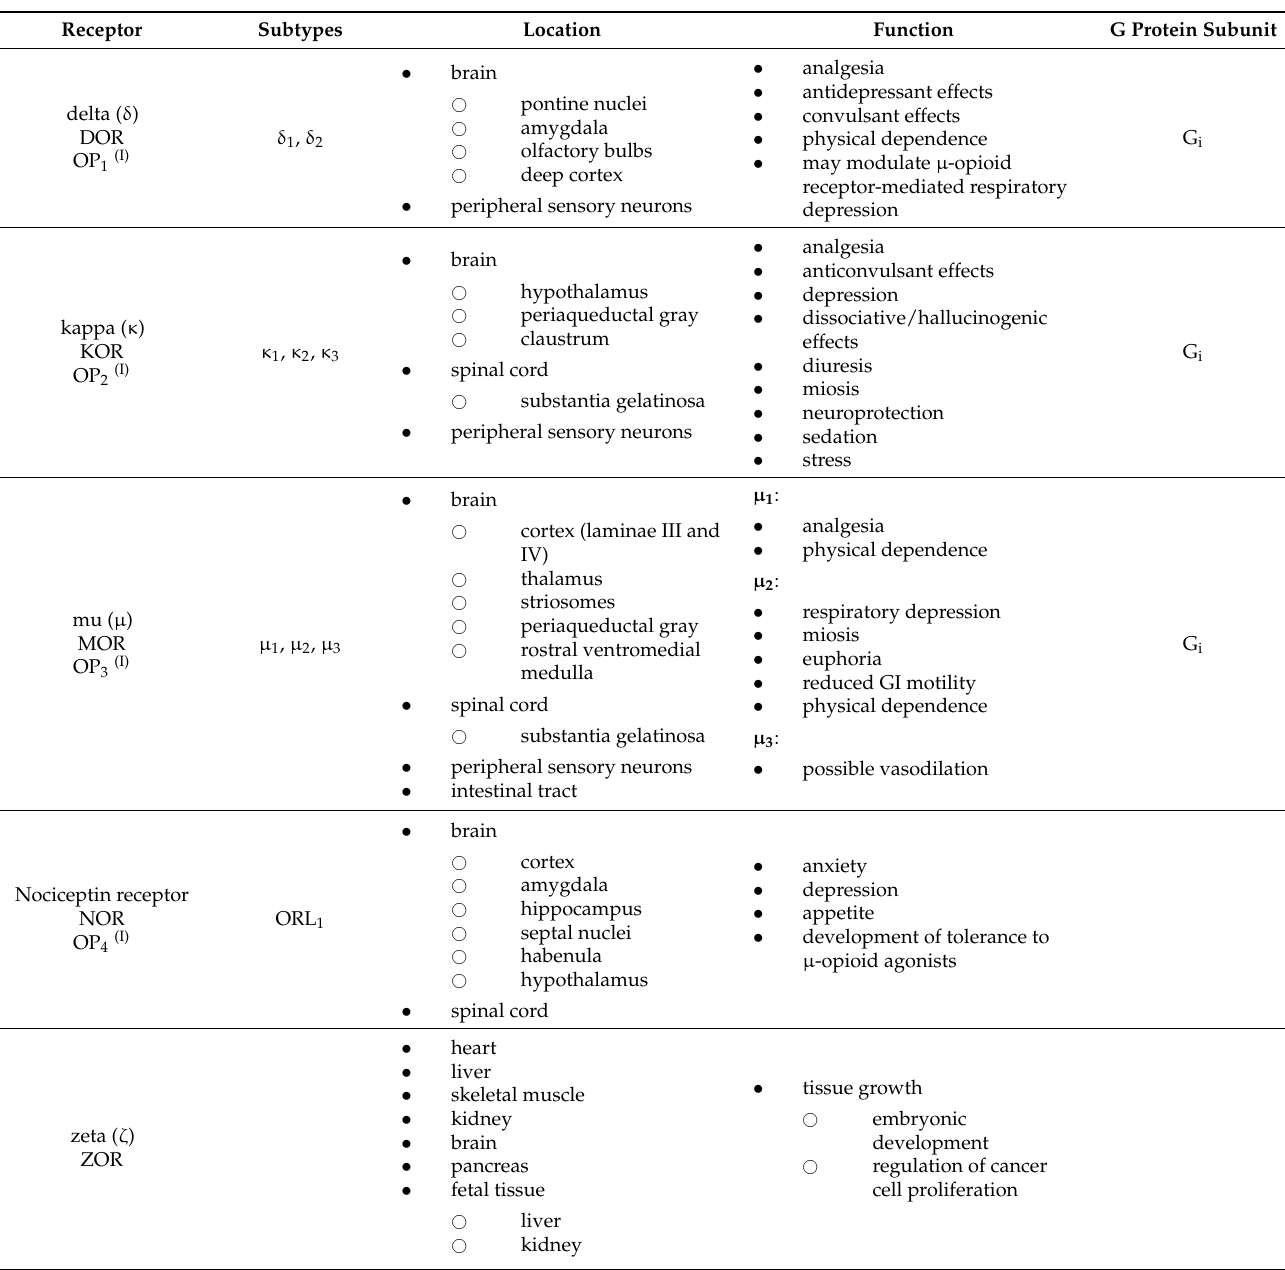
Table 1. Distribution of opioid receptors (ORs) in